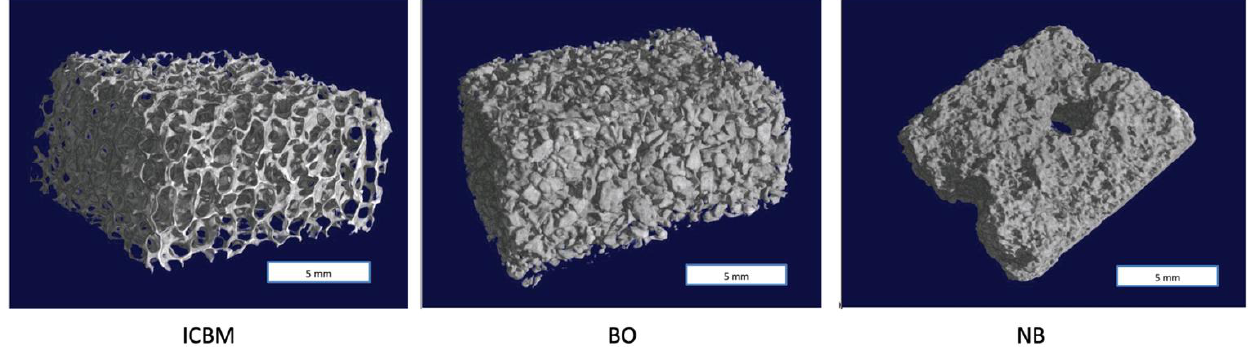
Figure 3. Micro-CT Images of the 1 × 1 × 0.5 cm 3 blocks of three-dimensional biomaterials. Insoluble Collagenous Bone Matrix (ICBM) appears spongious with large pores. BioOss (BO) almost shows a particulate structure whereas NanoBone (NB) displays a smoother surface with only little